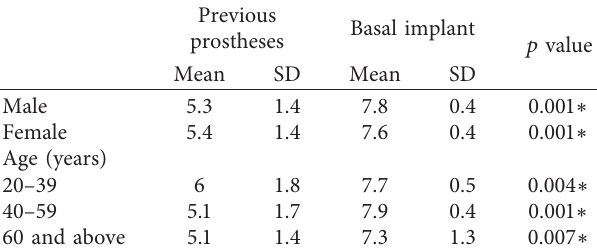
Table 7: Comparison of patients’ satisfaction with comfort, mastication, aesthetics, and speech with previous prosthesis and basal implant by gender and age